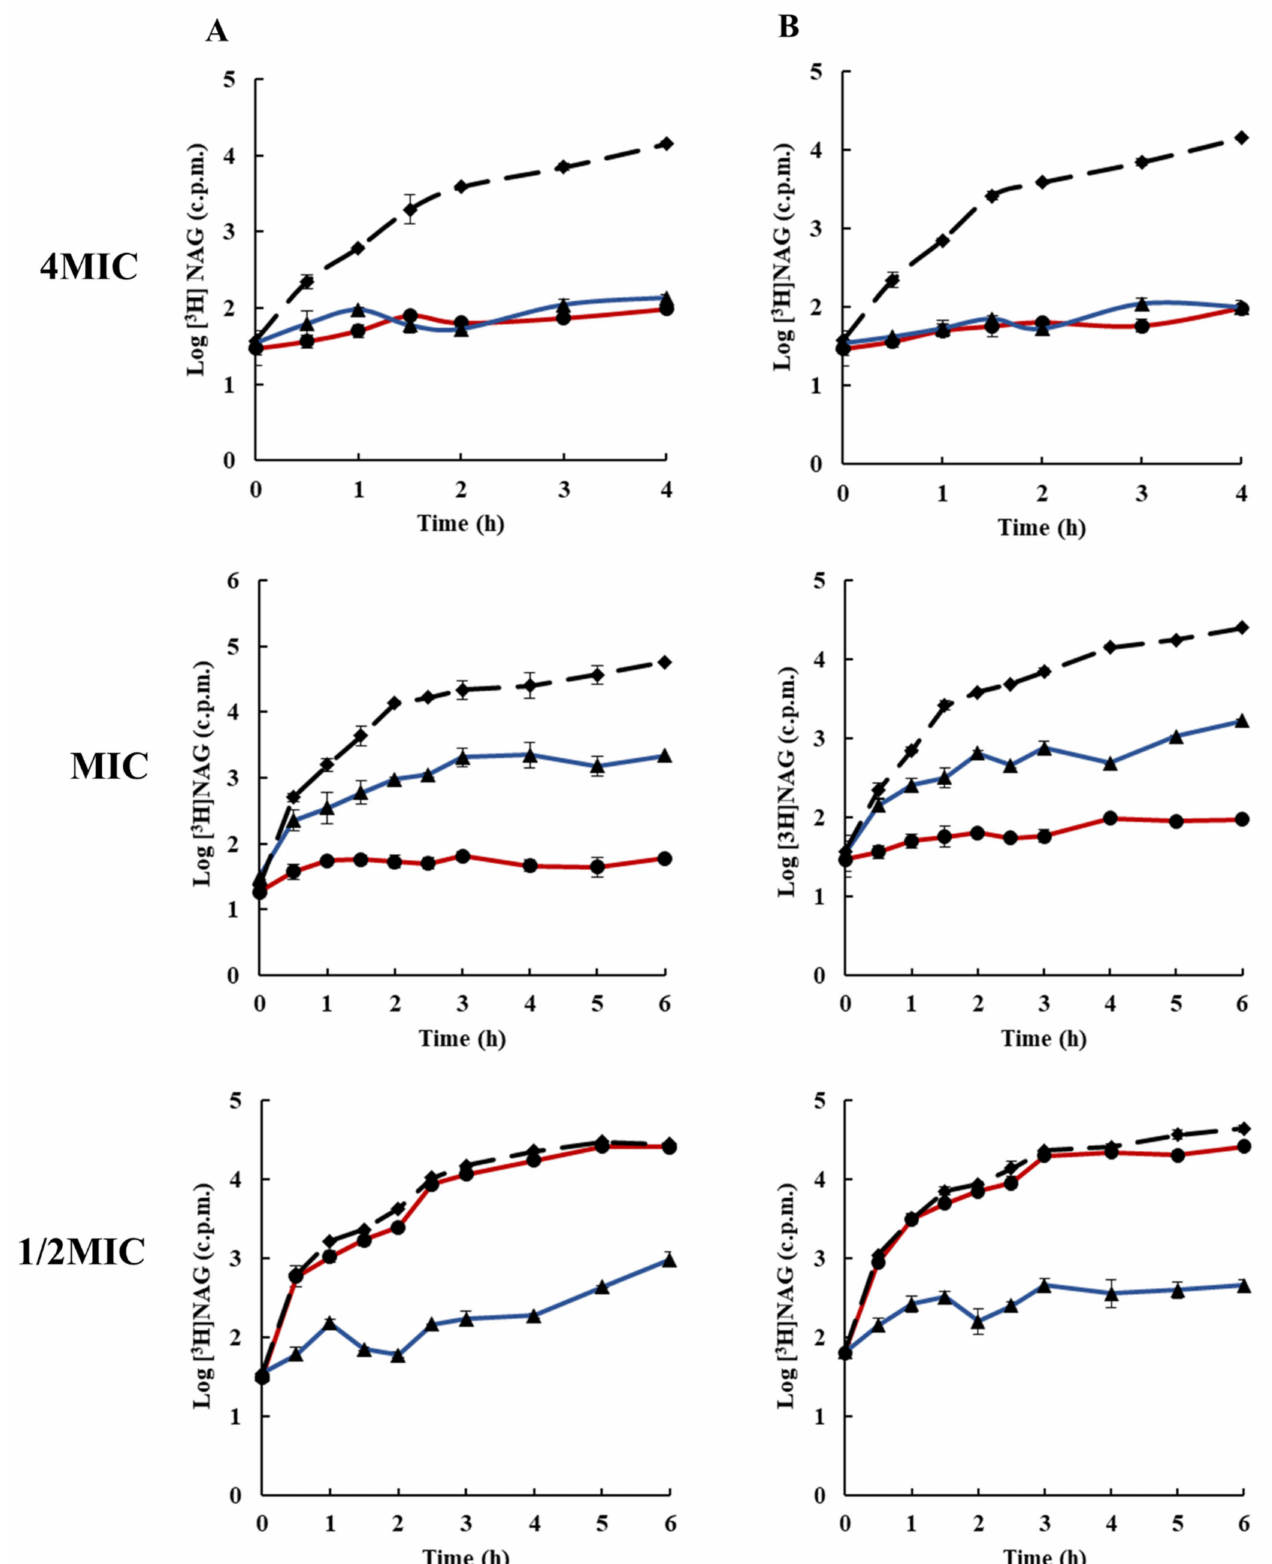
Figure 5. Effects of rhodomyrtone on cell wall synthesis at 4 × MIC, MIC, and 1/2 × MIC on ( A ) EMRSA-16 and ( B ) S. aureus ATCC 29213. Cell wall synthesis was determined by incorporation of N-acetyl-d-[1- 3 H]glucosamine. rhodomyrtone (blue ▲ ), vancomycin (red ● ), and 1% DMSO (broken line ). Each symbol indicates the mean ± SD for duplicates.